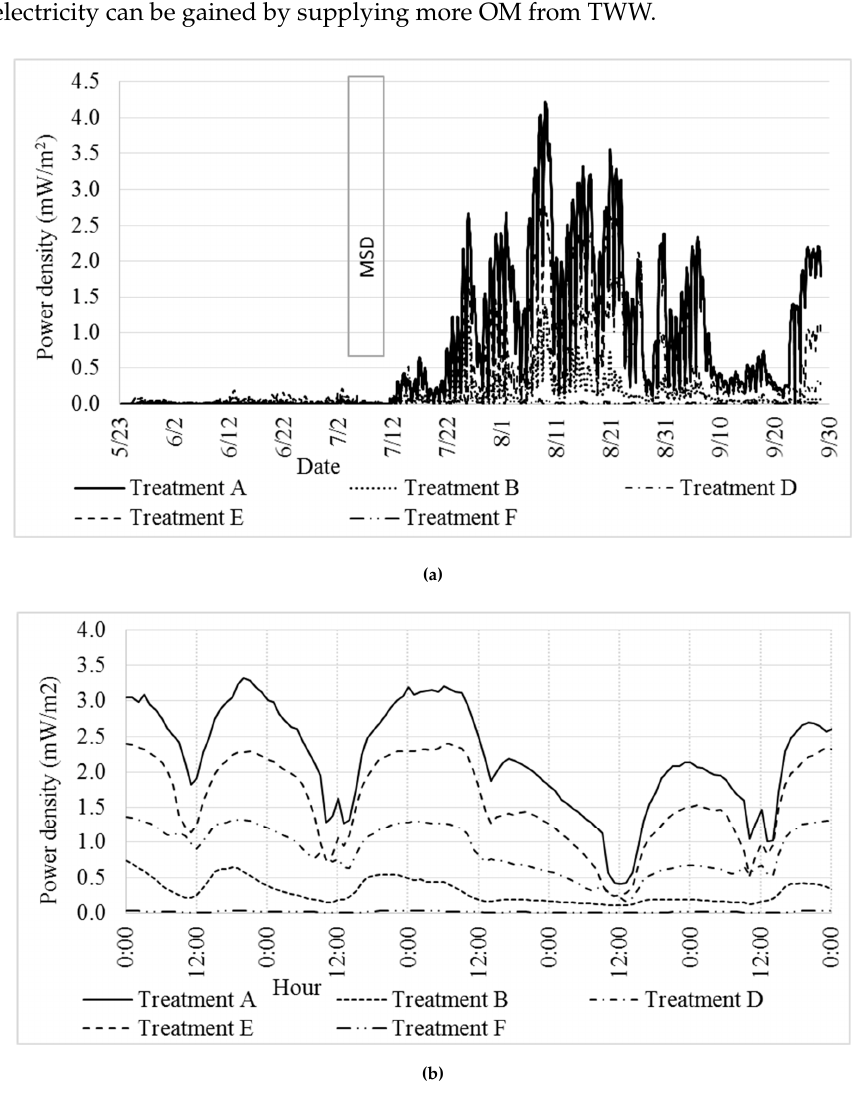
Figure 4. Power densities from the MFC systems throughout cultivation period ( a ) and only in five days of ripening stage ( b ). MSD means midsummer drainage to dry up soil